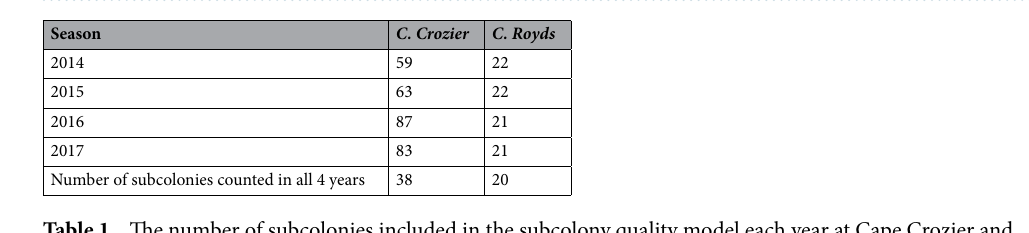
Table 1. The number of subcolonies included in the subcolony quality model each year at Cape Crozier and Cape Royds, Ross Island, Antarctica.